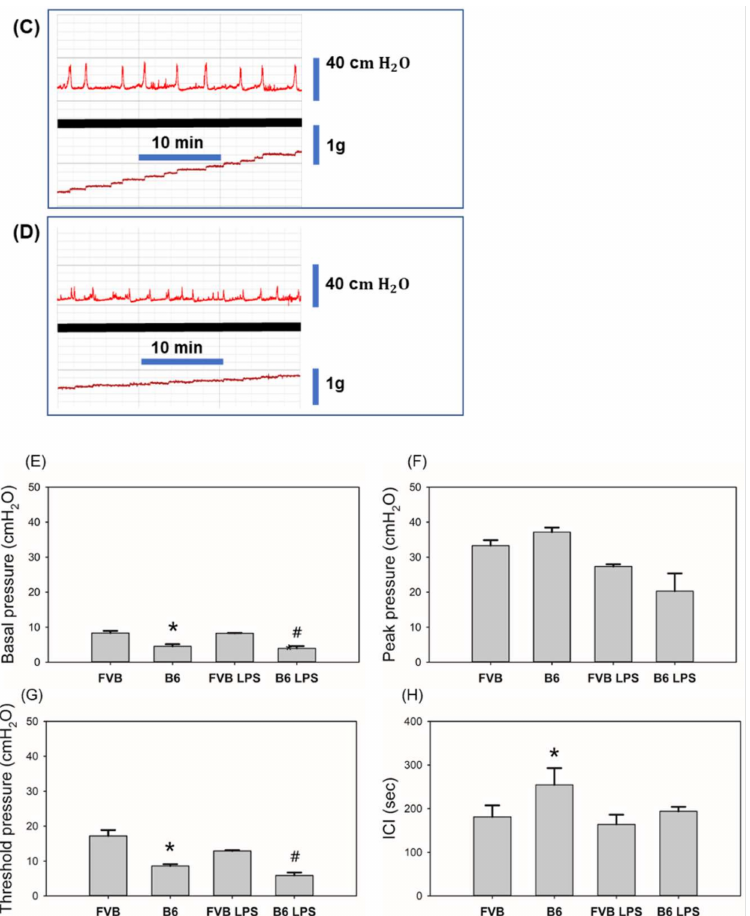
Figure 3. CMG data line charts of ( A ) FVB control, ( B ) B6 control, ( C ) lipopolysaccharide (LPS)- treated FVB, and ( D ) LPS-treated B6 mice. Bladder pressure is shown above the bold black line, and output volume below. CMG test results of all groups are shown for ( E ) basal pressure, ( F ) peak pressure, ( G ) threshold pressure, and ( H ) ICI. * B6 compared to FVB; # B6 LPS compared to FVB